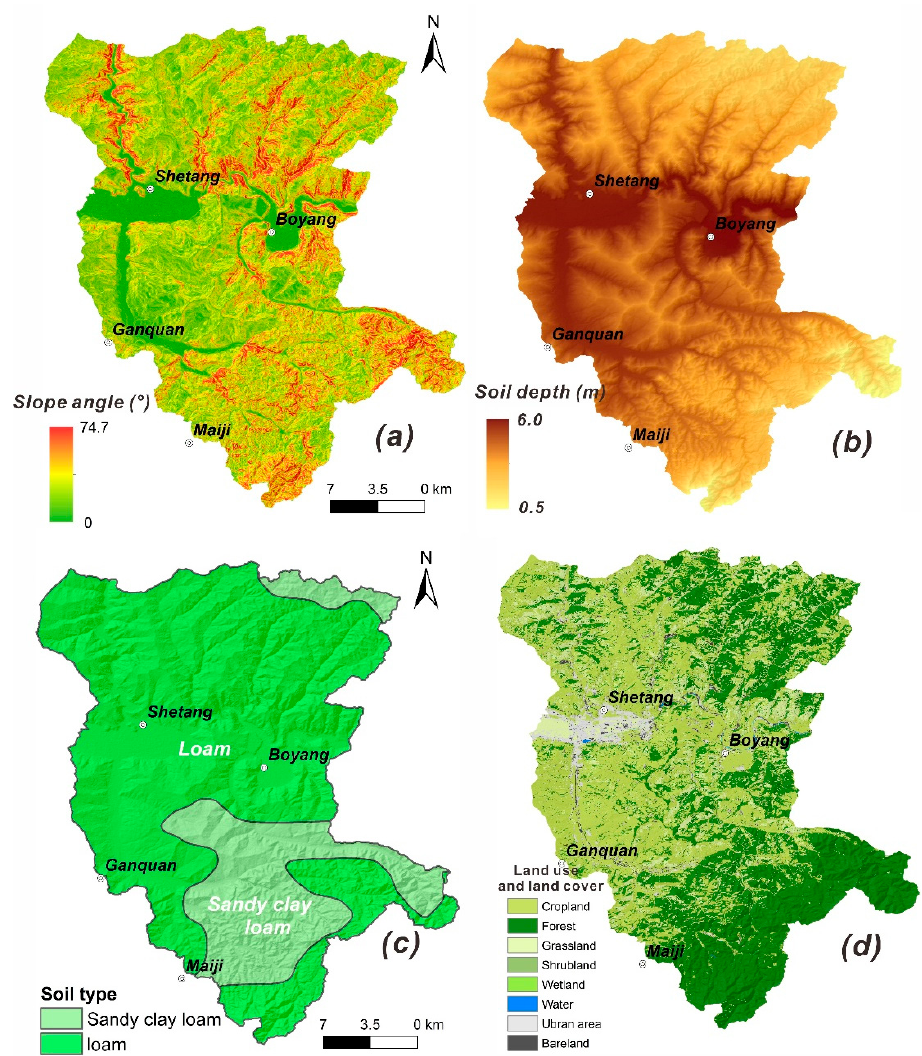
Figure 9. Map showing the input raster layers used for the FSLAM model: ( a ) Slope angle map. ( b ) Soil depth map. ( c ) Soil type map. ( d ) Land-use and land-cover (LULC) map. CN-9 and CN-10 represent two different soil types in the study area: CN-9 represents sandy clay loam, and CN-10 represents 𝑍 = 𝑍 − (cid:4672) (cid:3035) (cid:3284) (cid:2879)(cid:3035) (cid:3288)(cid:3284)(cid:3289) − 𝑍 ) (1) (cid:4673) (𝑍 (cid:3036) (cid:3040)(cid:3028)(cid:3051) (cid:3040)(cid:3028)(cid:3051) (cid:3040)(cid:3036)(cid:3041) (cid:3035) (cid:3288)(cid:3276)(cid:3299) (cid:2879)(cid:3035) (cid:3288)(cid:3284)(cid:3289)